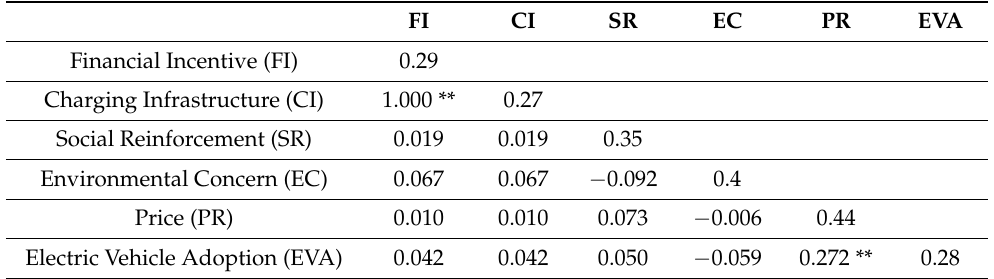
Table 4. Discriminant